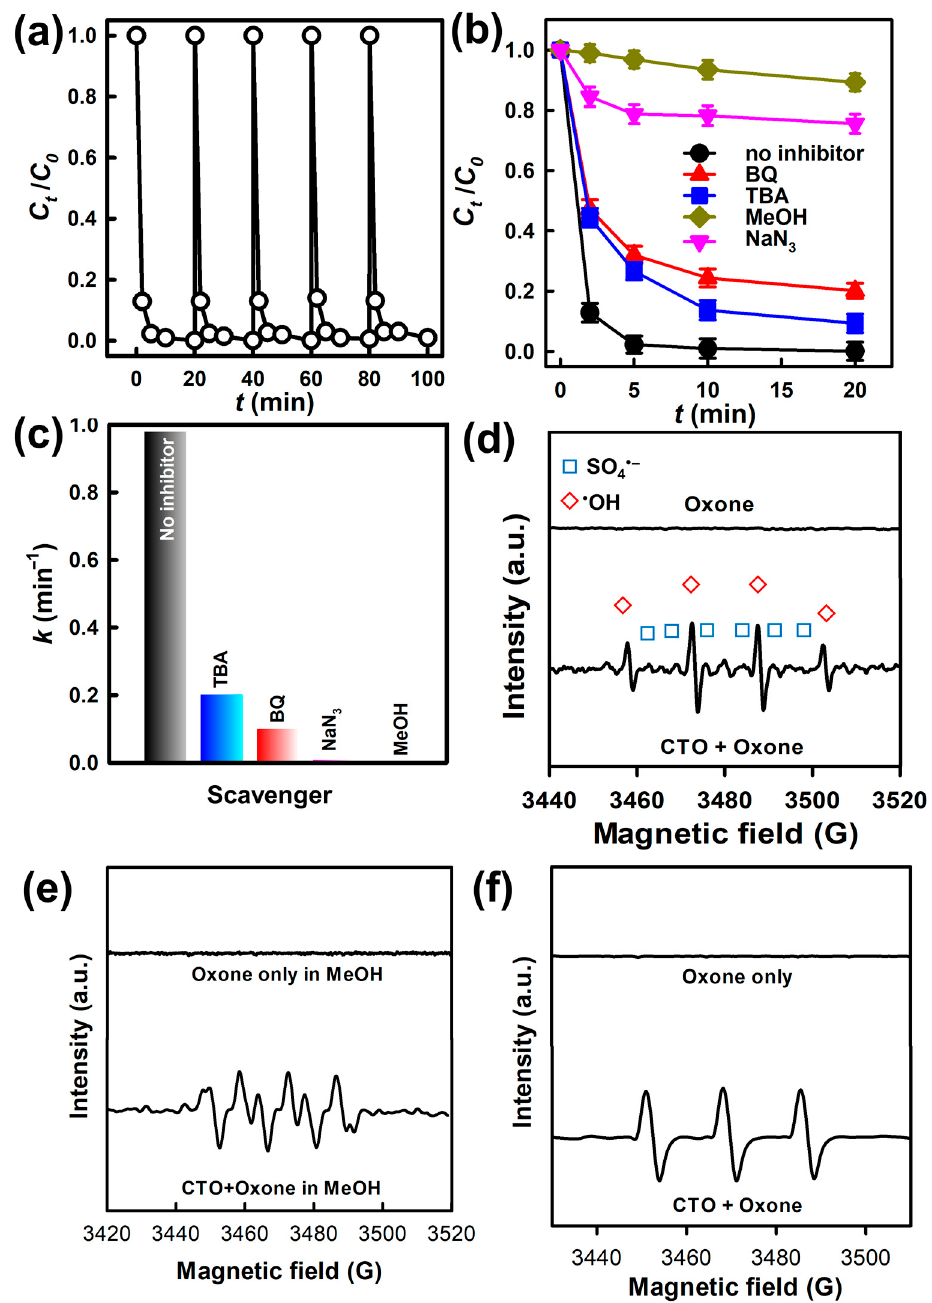
Figure 8. ( a ) Recyclability of CTO, ( b ) effect of inhibitors on BHPM degradation, and ( c ) the corre- sponding rate constants. EPR analyses of ( d ) DMPO-OH, DMPO-SO4, ( e ) superoxide, and ( f ) singlet oxygen (catalyst = 200 mg/L; oxone = 200 mg/L; T = 300 K).